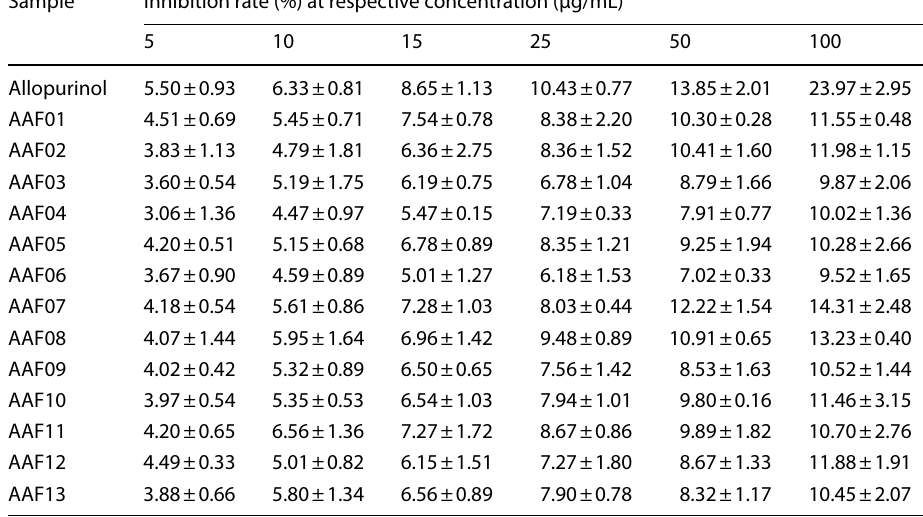
Table 2 Absolute differences between xanthine oxidase inhibition rates and normalized peak areas